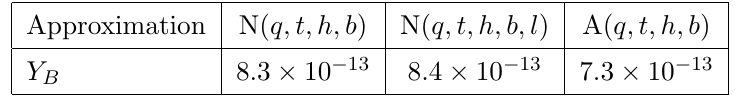
Table 4 . Baryon asymmetry Y B for a bottom source with (cid:3) b = 1 TeV and v w = 0 : 05 using di(cid:11)erent approximations discussed in the